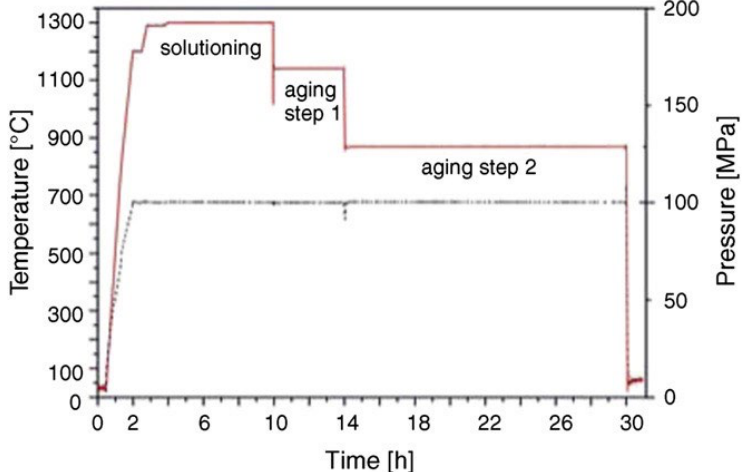
Figure 19. Profiles of the measured temperature (solid line) and pressure (dotted line) during the integrated HIP treatment that consisted of solutioning at 1300 °C and two-step aging at 1140 °C (4 h) and 870 °C (16 h), 100 MPa [32] .